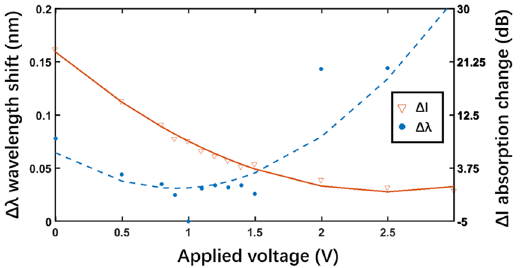
Figure 6. Spectra shift Δ λ and absorption variation Δ l for different applied